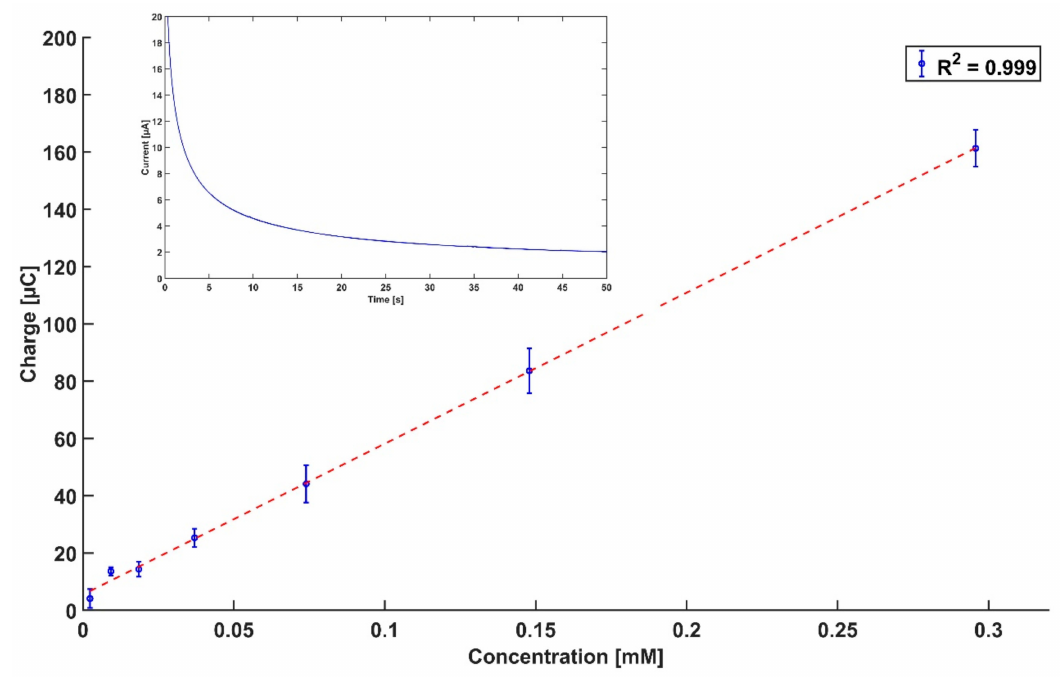
Figure 3. Charge as a function of concentration calculated by integrating the measured current at a time interval of 50 s ( n = 3, replicates from independent dilution series). The inset shows the amperometric measurement of 0.3 mM of Gly; the full dataset is presented in Supplementary Material, Figure